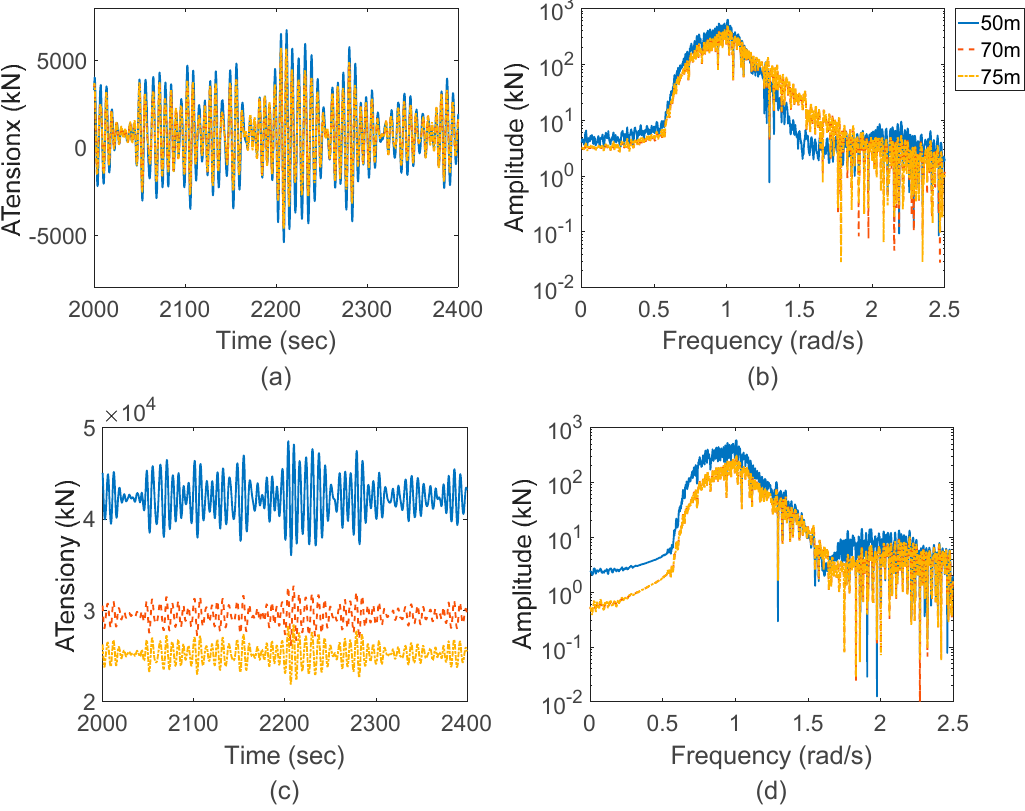
Figure 9. Tensions on the hinged joint. ( a ) Time histories of x-direction Tension on the articulated joint ( b ) Response spectra of x-direction Tension on the articulated joint ( c ) Time histories of y-direction Tension on the articulated joint ( d ) Response spectra of y-direction Tension on the articulated